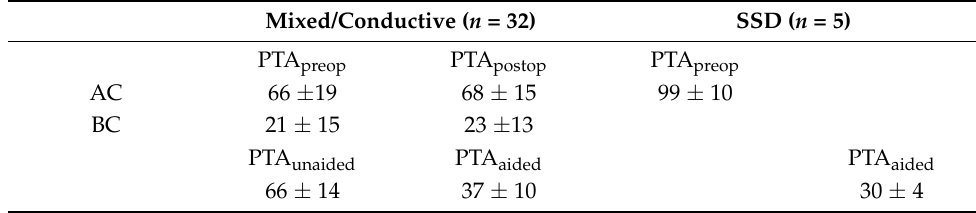
Table 2. Audiologic results.